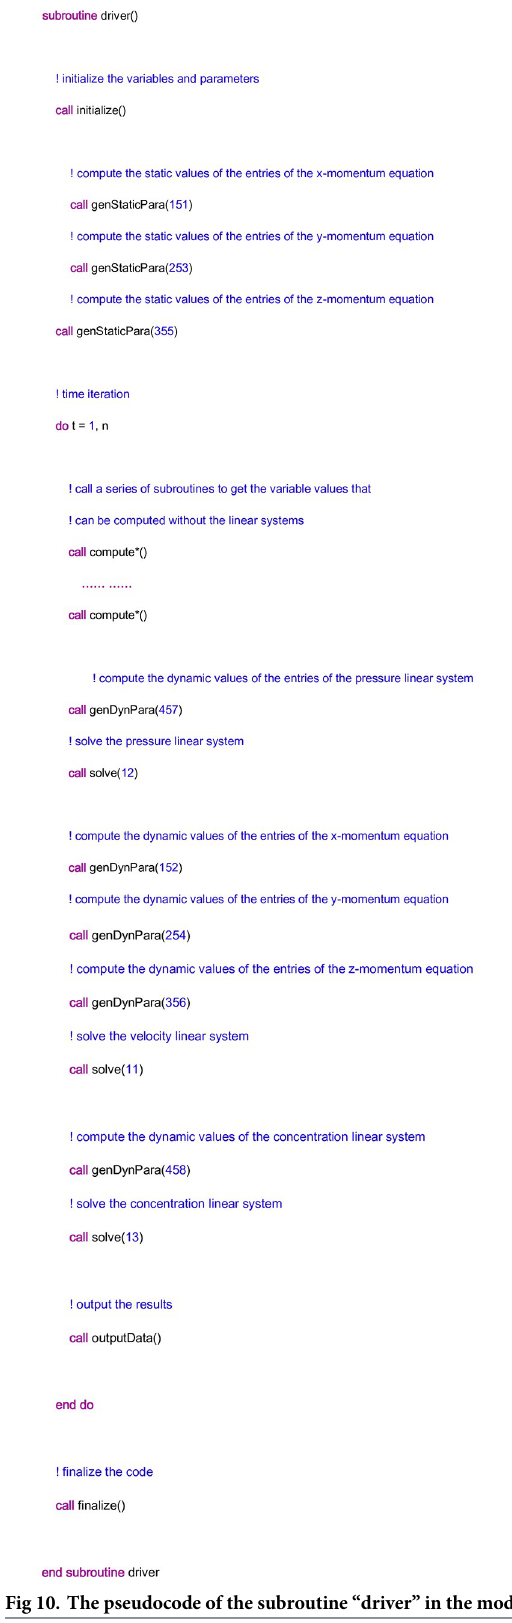
Fig 10. The pseudocode of the subroutine “driver” in the module “Driver”. https://doi.org/10.1371/journal.pone.0261134.g010 PLOS ONE | https://doi.org/10.1371/journal.pone.0261134 February 3,